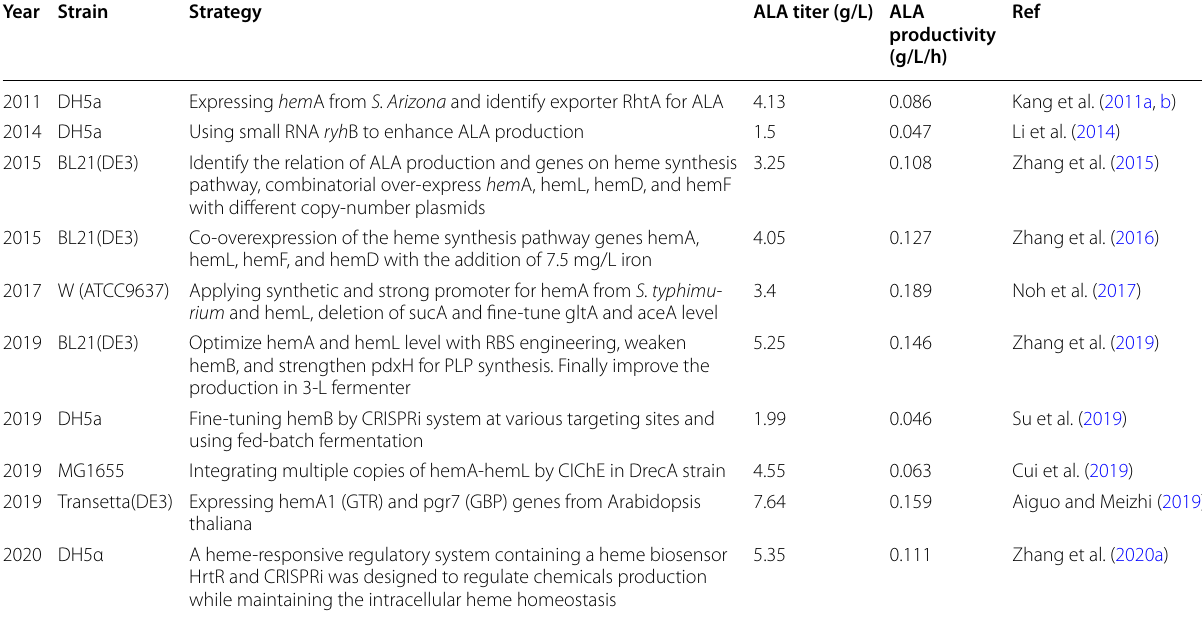
Table 3 Production of 5‑ALA via C5 pathway in E.